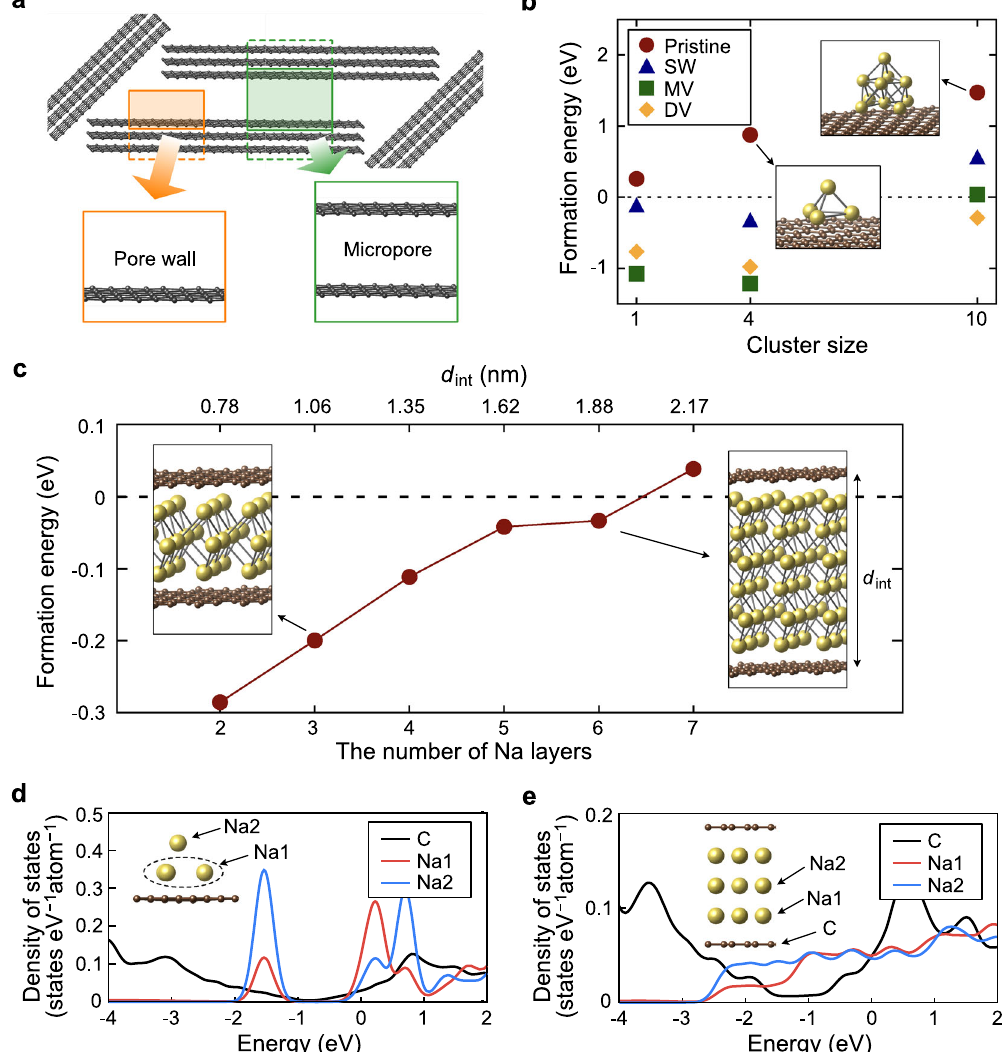
Fig. 3 Formation energy and density of states of Na cluster in micropore. a Schematic fi gure of micropore surrounded by graphitic domains. Simplifying the geometry, single-layer graphene is used instead of graphite. The formation energy of b the adsorption of Na cluster on the various defective graphene and c Na slab inside slit-shaped graphene pore. Projected density of states of d Na cluster on graphene and e Na slab inside slit-shaped pore (Fermi level is set to 0). Insets show the Na – C